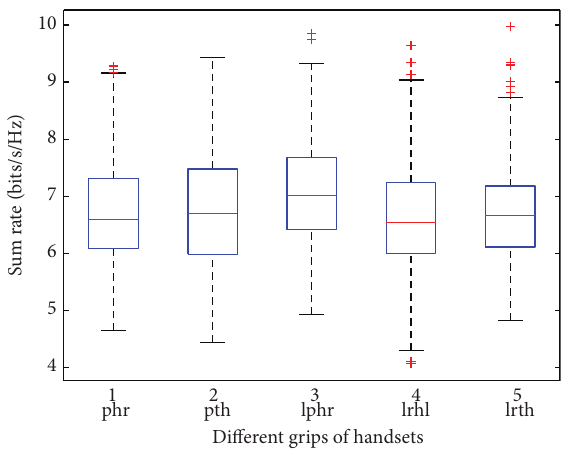
Figure 5: Capacity of different grips at high